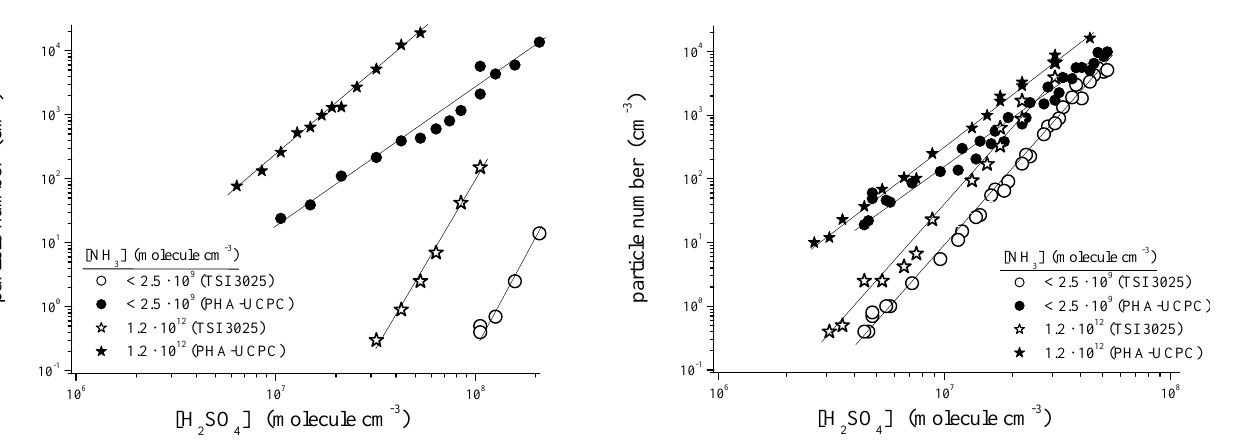
Fig. 10a. Particle numbers as a function of H 2 SO 4 concentration in absence and presence of NH 3 addition; total gas flow: 30lmin − 1 STP. Relative humidity: 13%.